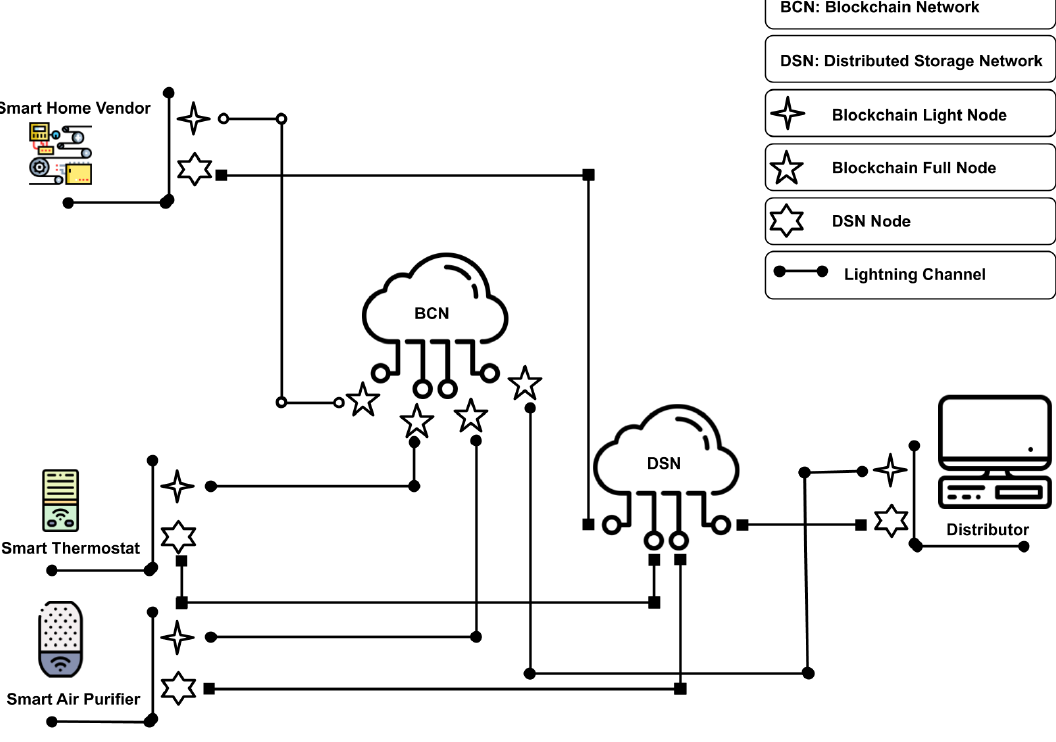
Figure 1. P 4 UIoT High level architecture